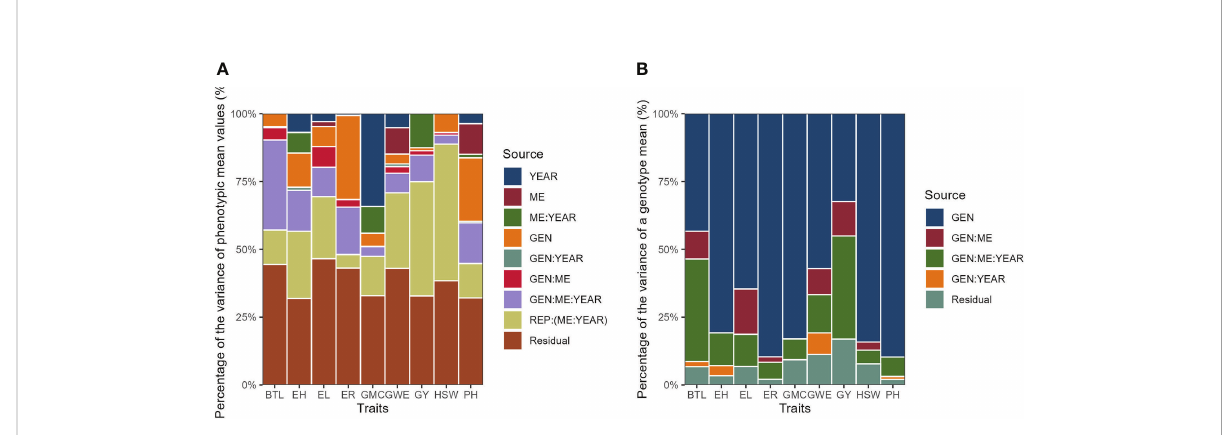
FIGURE 5 Percentage of the variance of phenotypic mean values (A) and percentage of the variance of a genotype mean (B)